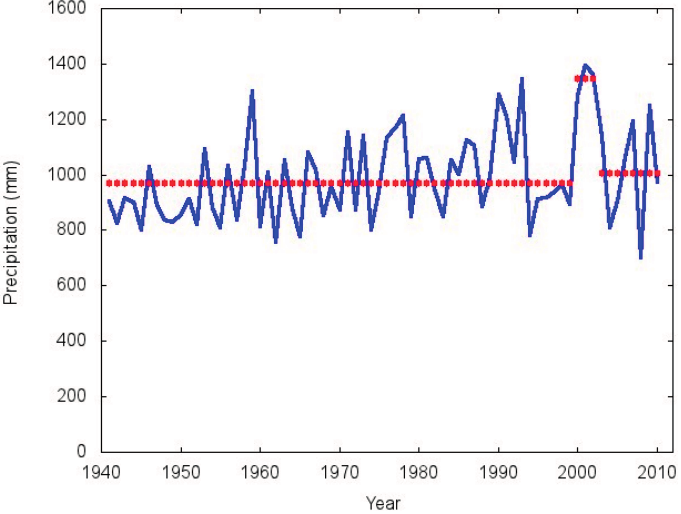
Figure 5. Annual precipitation and means for sub-periods in the Rolling Pampa sub-region by Hubert’s segmentation method.